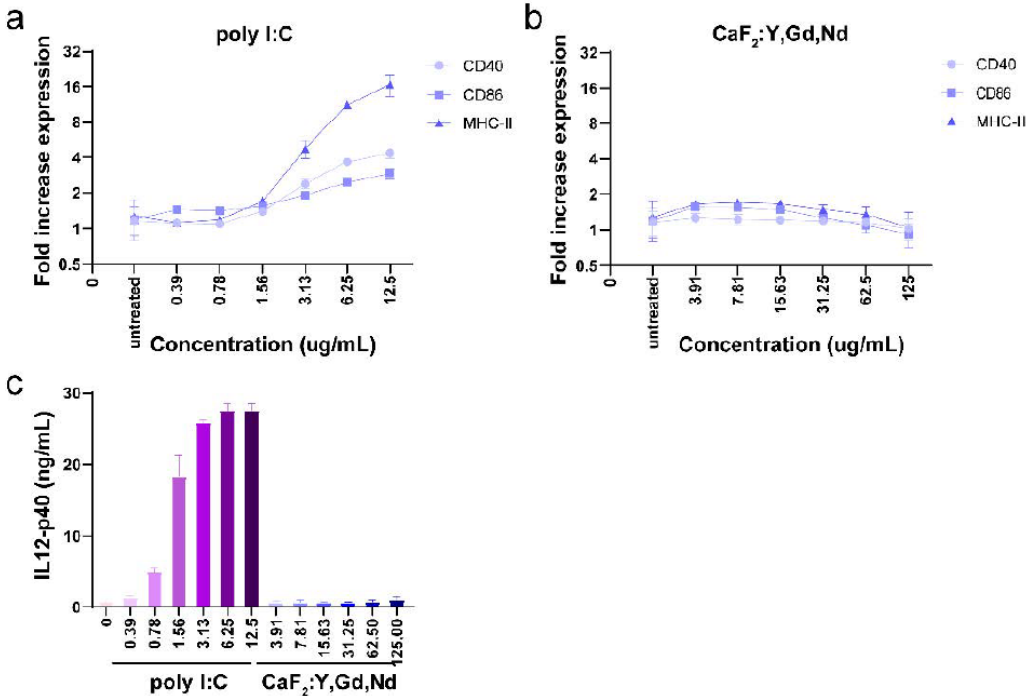
Figure 7. Immunogenicity of CaF 2 :Y,Gd,Nd NPs measured by flow cytometry and IL-12 ELISA. D1 DCs were incubated with different concentrations of CaF 2 :Y,Gd,Nd NPs for 24 h. ( a ) Expression of CD40, CD86, and MHC-II in poly I:C group (compared to untreated group); ( b ) expression of CD40, CD86, and MHC-II in CaF 2 :Y,Gd,Nd NPs group (compared to untreated group); ( c ) production of IL-12 (ng/mL) was measured using ELISA for poly I:C group and CaF 2 :Y,Gd,Nd NPs group. Data are expressed as mean ± SD for three independent experiments.